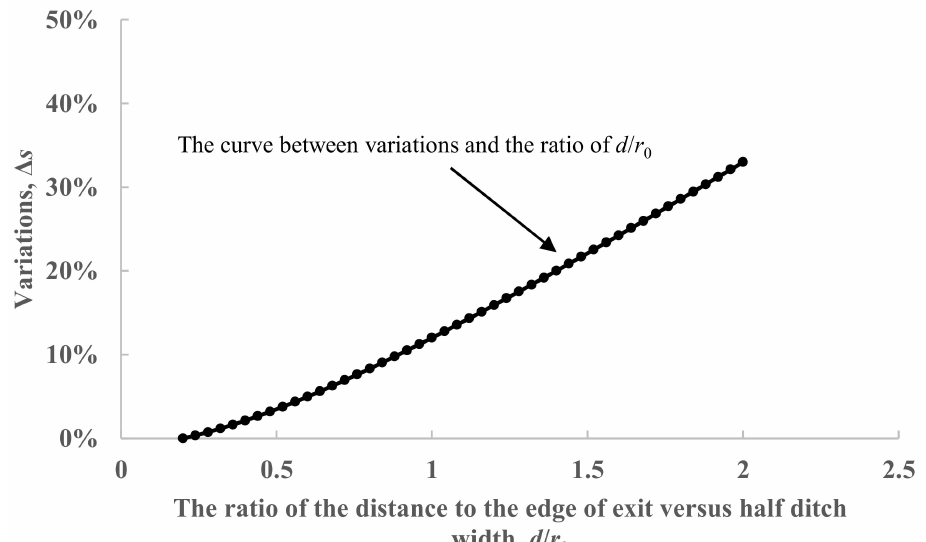
Figure 6. Plot of the percentage difference of models versus the ratio between the distance to the edge of the exit and half ditch